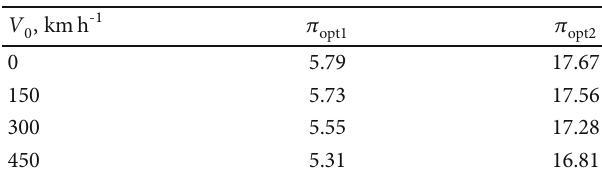
Table 4: Variations in critical compressor pressure ratios π H . π crit2 with